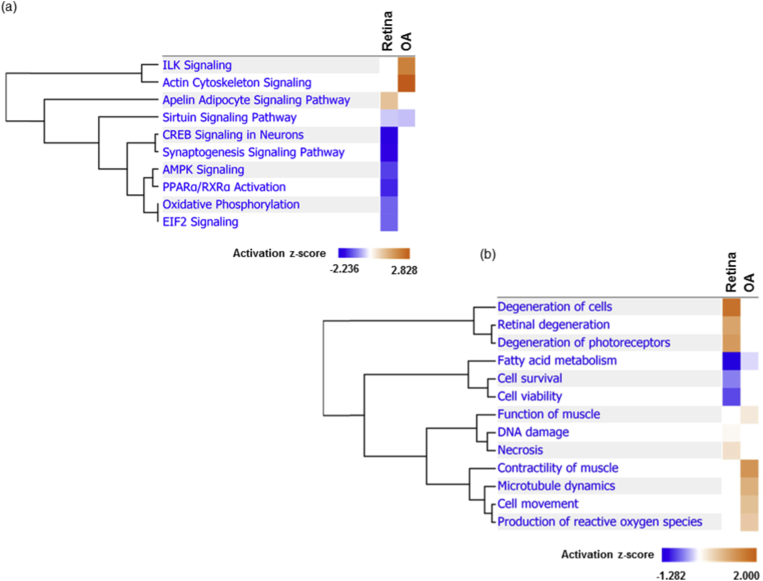
Comparison analysis. The hierarchical clustering of the most significantly affected (a) canonical pathways and (b) diseases and biological functions comparing both ophthalmic artery and retina. Blue indicates negative and orange indicates positive regulation based on the activation z-scores of < -2 and > 2 for canonical pathway comparison and < -1 and > 2 for diseases and biological functions. OA: Ophthalmic artery. (For interpretation of the references to colour in this figure legend, the reader is referred to the Web version of this article.)